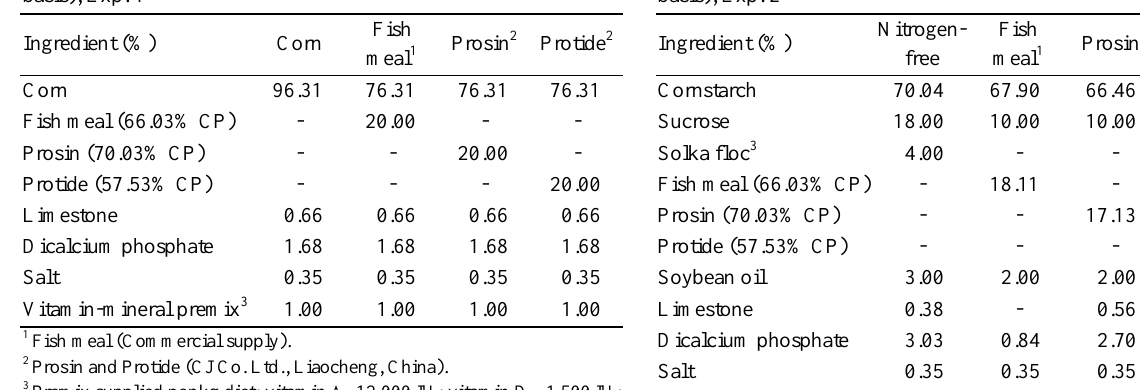
Table 3. Ingredient composition of experimental diets containing fish meal and single-cell proteins (Prosin and Protide)